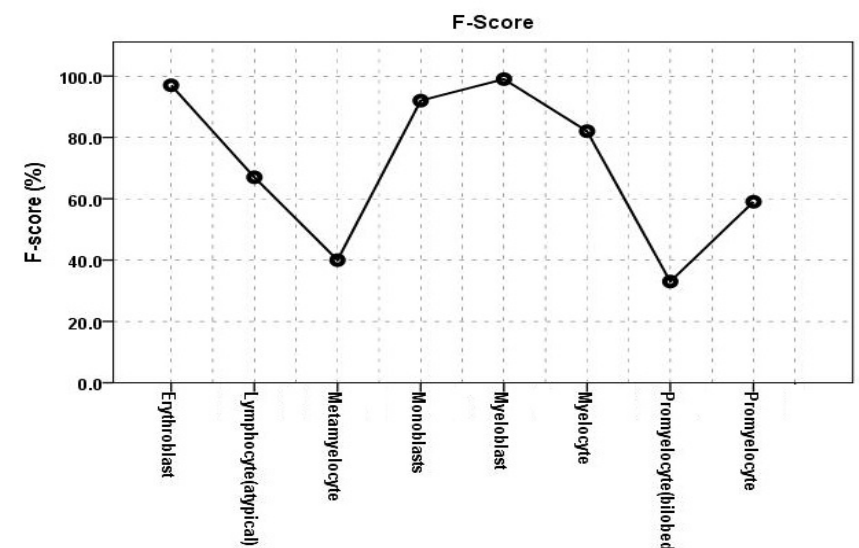
Figure 13. F-scores of Stage II: DCAE-CNN atypical WBC classification.